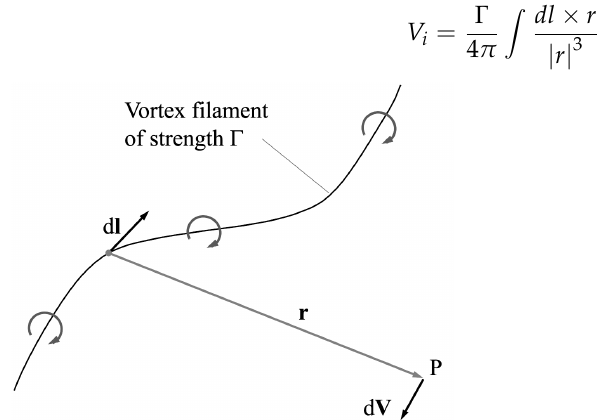
Figure 2. Vortex filament and illustration of the Biot–Savart law [18].